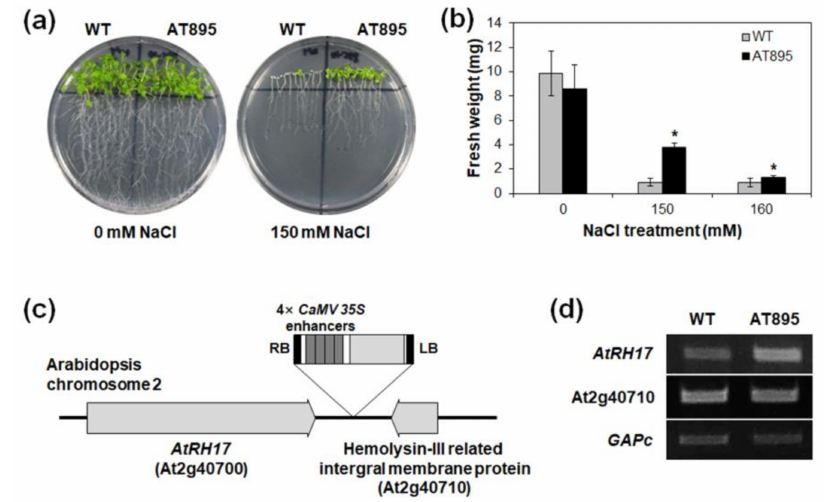
Figure 1. Isolation of the AtRH17 gene involved in salt-stress tolerance from activation tagging line analysis. ( a , b ) Responses of wild type (WT) and AT895 seedlings to 0, 150, and 160 mM NaCl. Seven-day-old seedlings were transferred onto NaCl-containing Murashige and Skoog (MS) agar media, and photographs were taken seven days after NaCl treatment. Fresh weight (FW) was measured seven days after NaCl treatment. In ( b ), error bars represent standard deviation ( n = 30 plants) and * indicate t -test p < 0.05. ( c ) Schematic map of the T-DNA insertion position in the genomic DNA of AT895. ( d ) Expression analysis of AtRH17 (At2g40700) and hemolysin-III related integral membrane protein gene (At2g40710) in the AT895 plants by semi-quantitative reverse transcription (RT)-PCR. GAPc was used as an internal